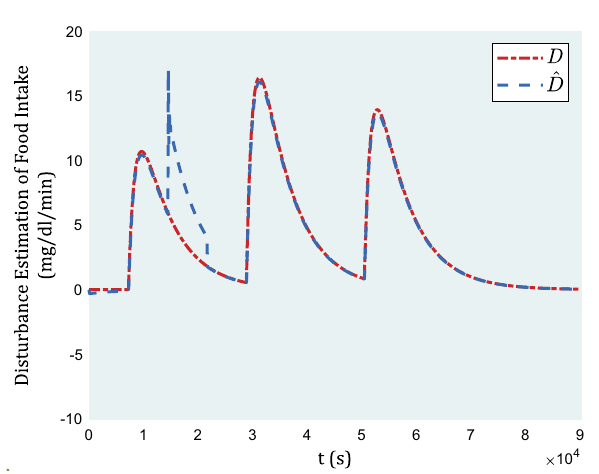
Figure 12. Disturbance estimation in the 2-h absence of